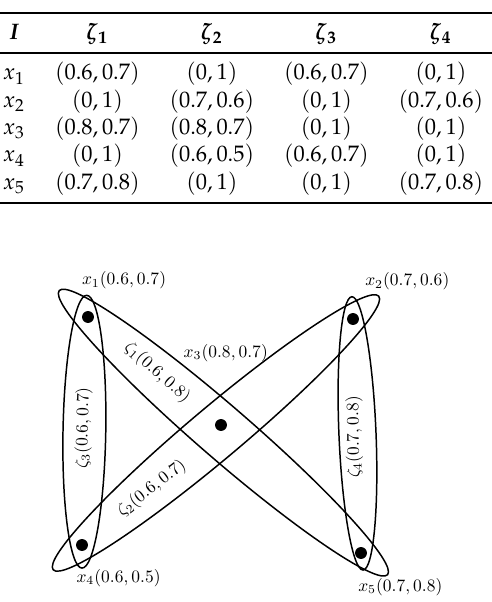
Table 2. Incidence matrix of